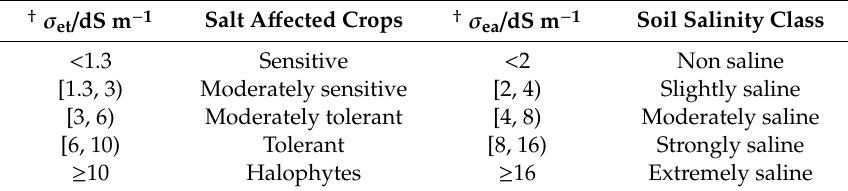
Table 11. Soil salinity assessment scheme for agriculture based on the threshold-slope model of crop yield decline. Re-elaborated from Richards et al. [58] and Ayers and Westcot [59]. † σ / dS m − et